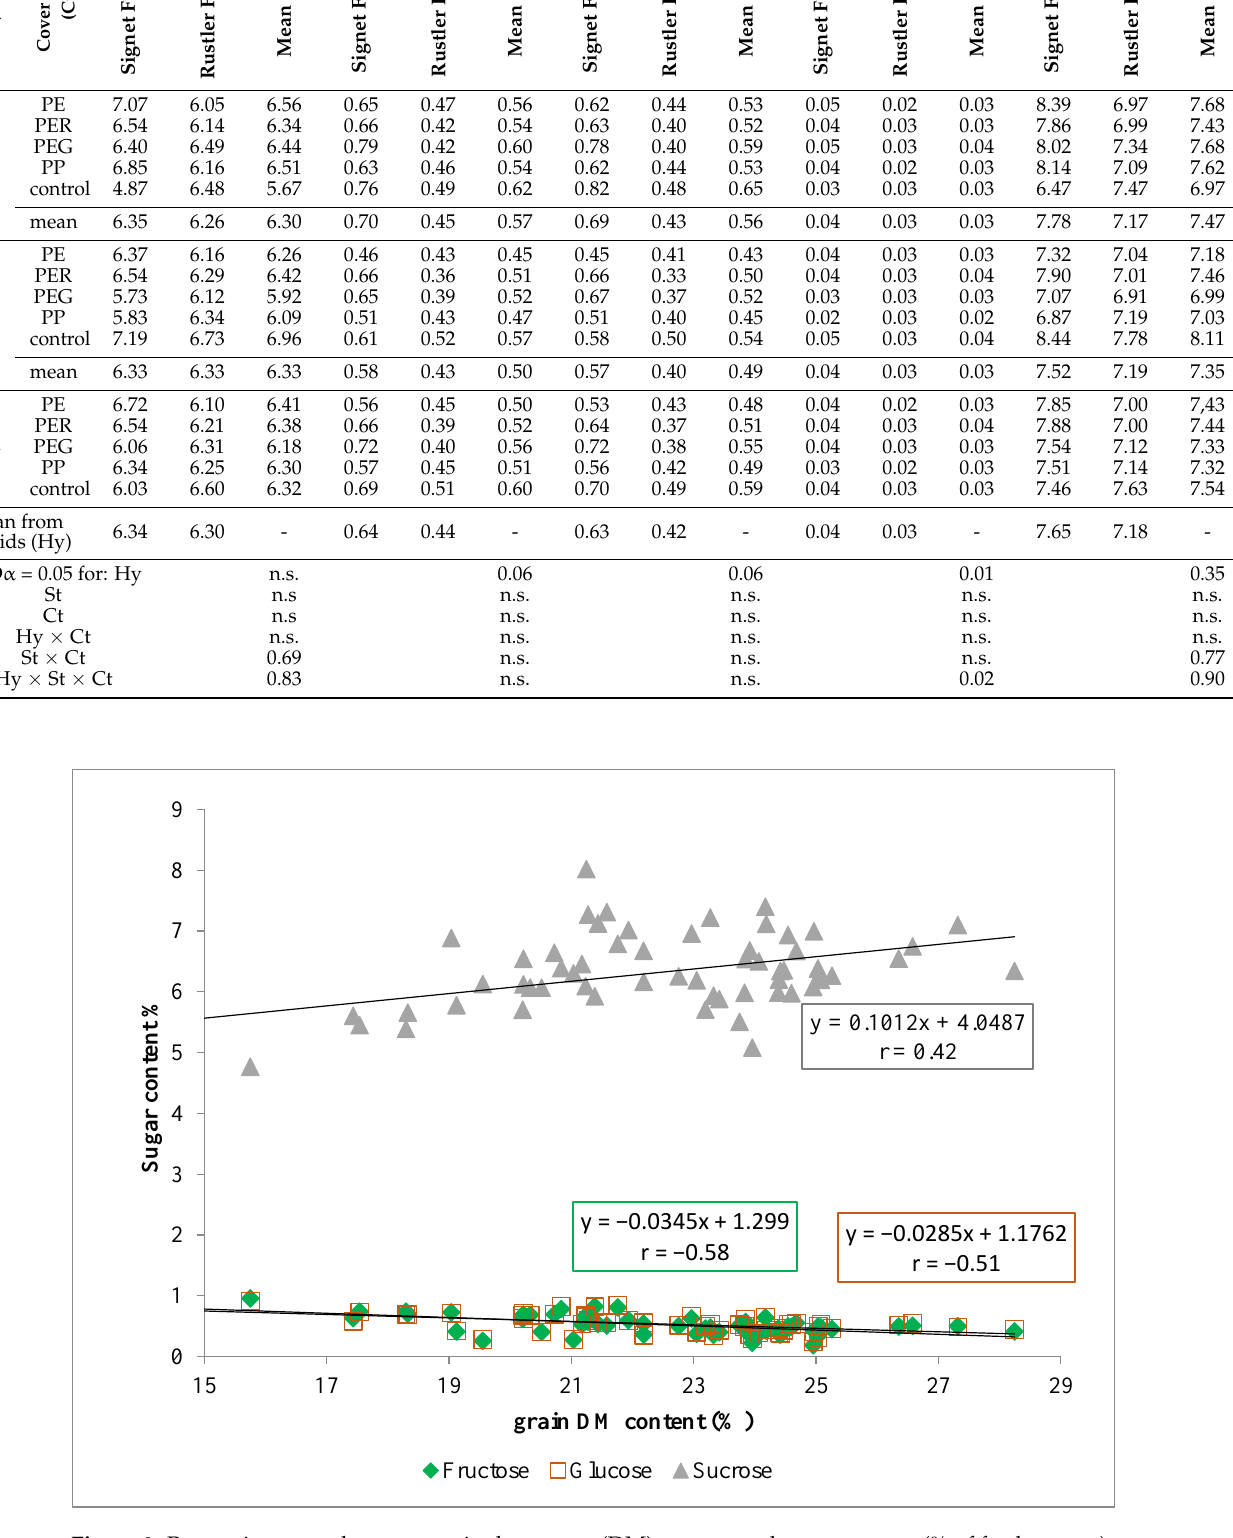
Figure 4. Regression curve between grain dry matter (DM) content and sugar ratio (% of fresh matter).